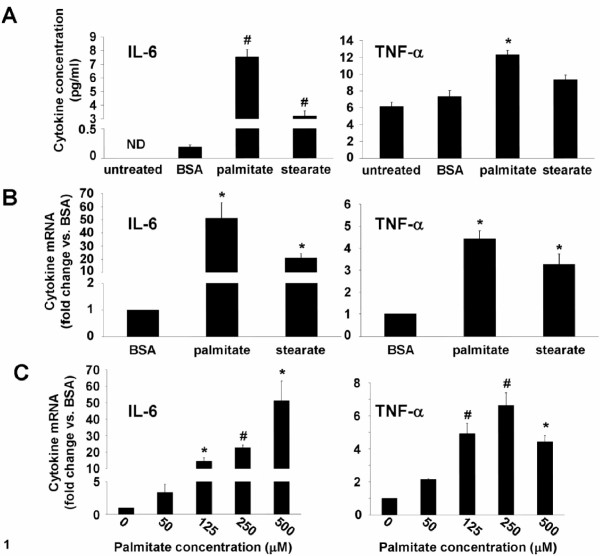
Saturated NEFA stimulate IL-6 and TNF-α production. A, IL-6 and TNF-α concentration in 24-hour conditioned media from THP-1 cells that were untreated or stimulated with 500 μM palmitate or stearate, or NEFA- and endotoxin-free BSA. B, IL-6 and TNF-α mRNA expression in THP-1 cells stimulated as in A for 12 hours. C, IL-6 and TNF-α mRNA expression in THP-1 cells stimulated with the indicated concentrations of palmitate for 12 hours. Values are means ± SE (n = 3-4). *, p < 0.05, # p < 0.01 versus BSA treatment, ND - below the limit of detection.